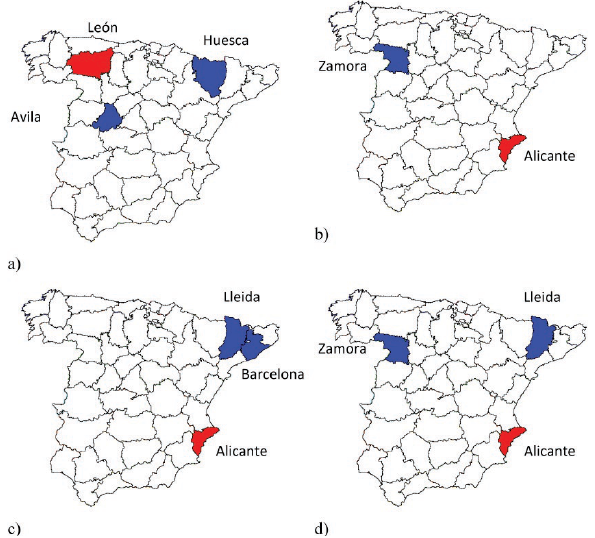
Fig. 6. Positive (red) and negative (blue) significant correla- tions between hail damage and minimum summer temperature for (a) grapes, (b) wheat, (c) barley, and (d) all winter grains. of the crop in Spanish agriculture. The crops considered were grapes, wheat, barley and all winter grains (including wheat and